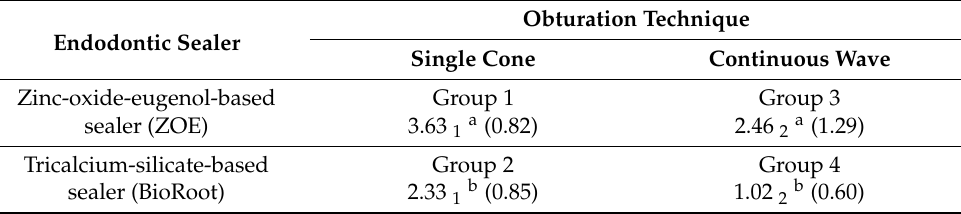
Table 2. Mean values (mm) and standard deviations (mm) of the microleakage in each experimental group organized according to the considered factors: endodontic sealer and obturation technique. Endodontic Sealer